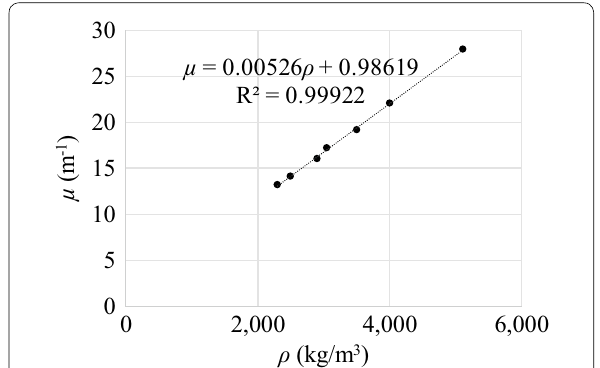
Fig. 3 Linear attenuation coefficient of concrete as a function of density at a photon energy of 1.25 MeV, per Bashter (1997).